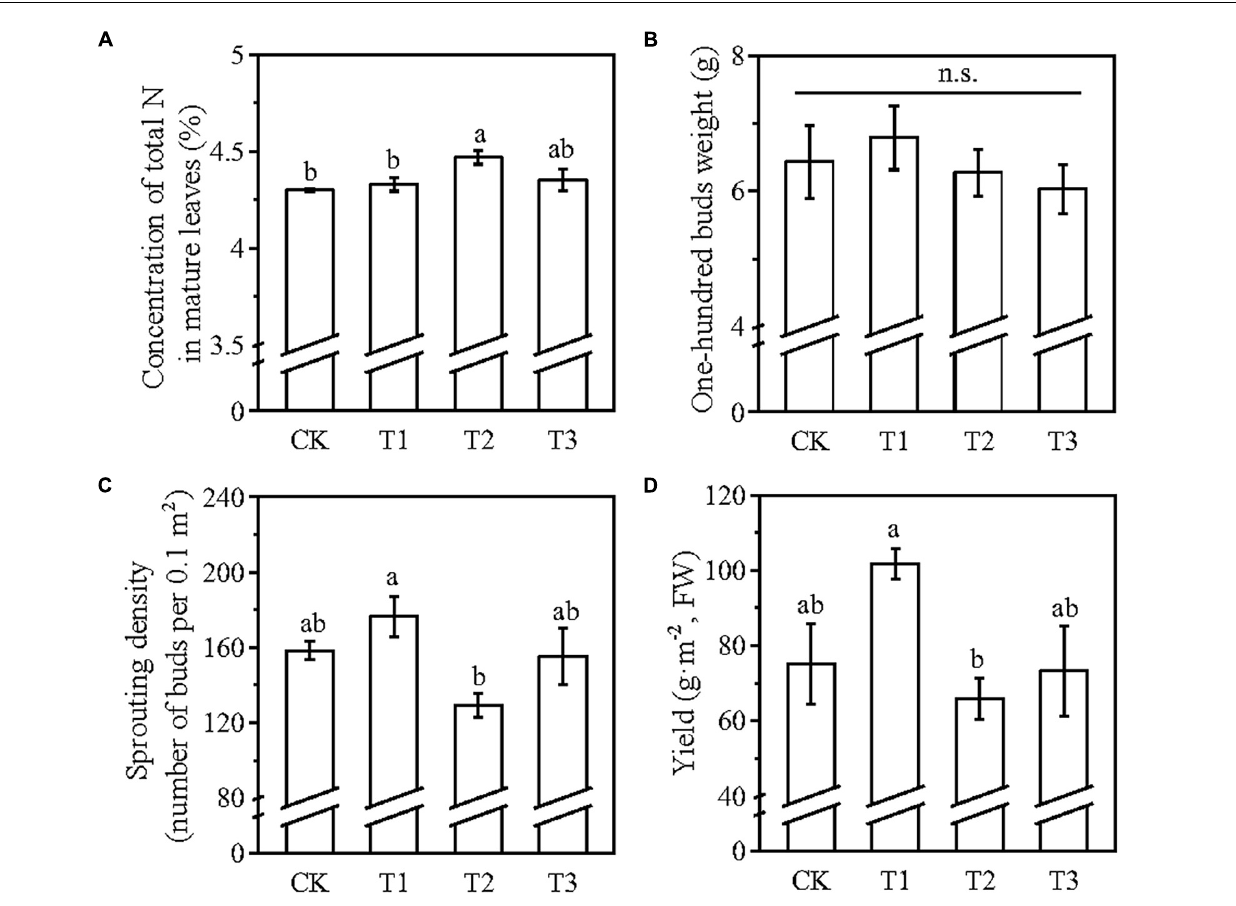
FIGURE 4 | The effect of different types of foliar fertilizers on the total N concentrations of the mature leaves before the sprouting of dormant buds (A) , the 100 buds weight (B) , sprouting density (C) , and yield of spring tea (D) . FW, fresh weight. T1, foliar application of amino acid liquid fertilizer; T2, foliar application of 2% (w/v) urea; T3, foliar application of a commercially available auxin-containing fertilizer; CK, foliar application of water. Data presented mean ± SE; n = 4 in panel (A) , 6 in panel (C) , 3 in panel (B,D) . Lowercase letters indicated significant differences ( P < 0.05; ANOVA, followed by the Duncan test). n.s., no significant difference.